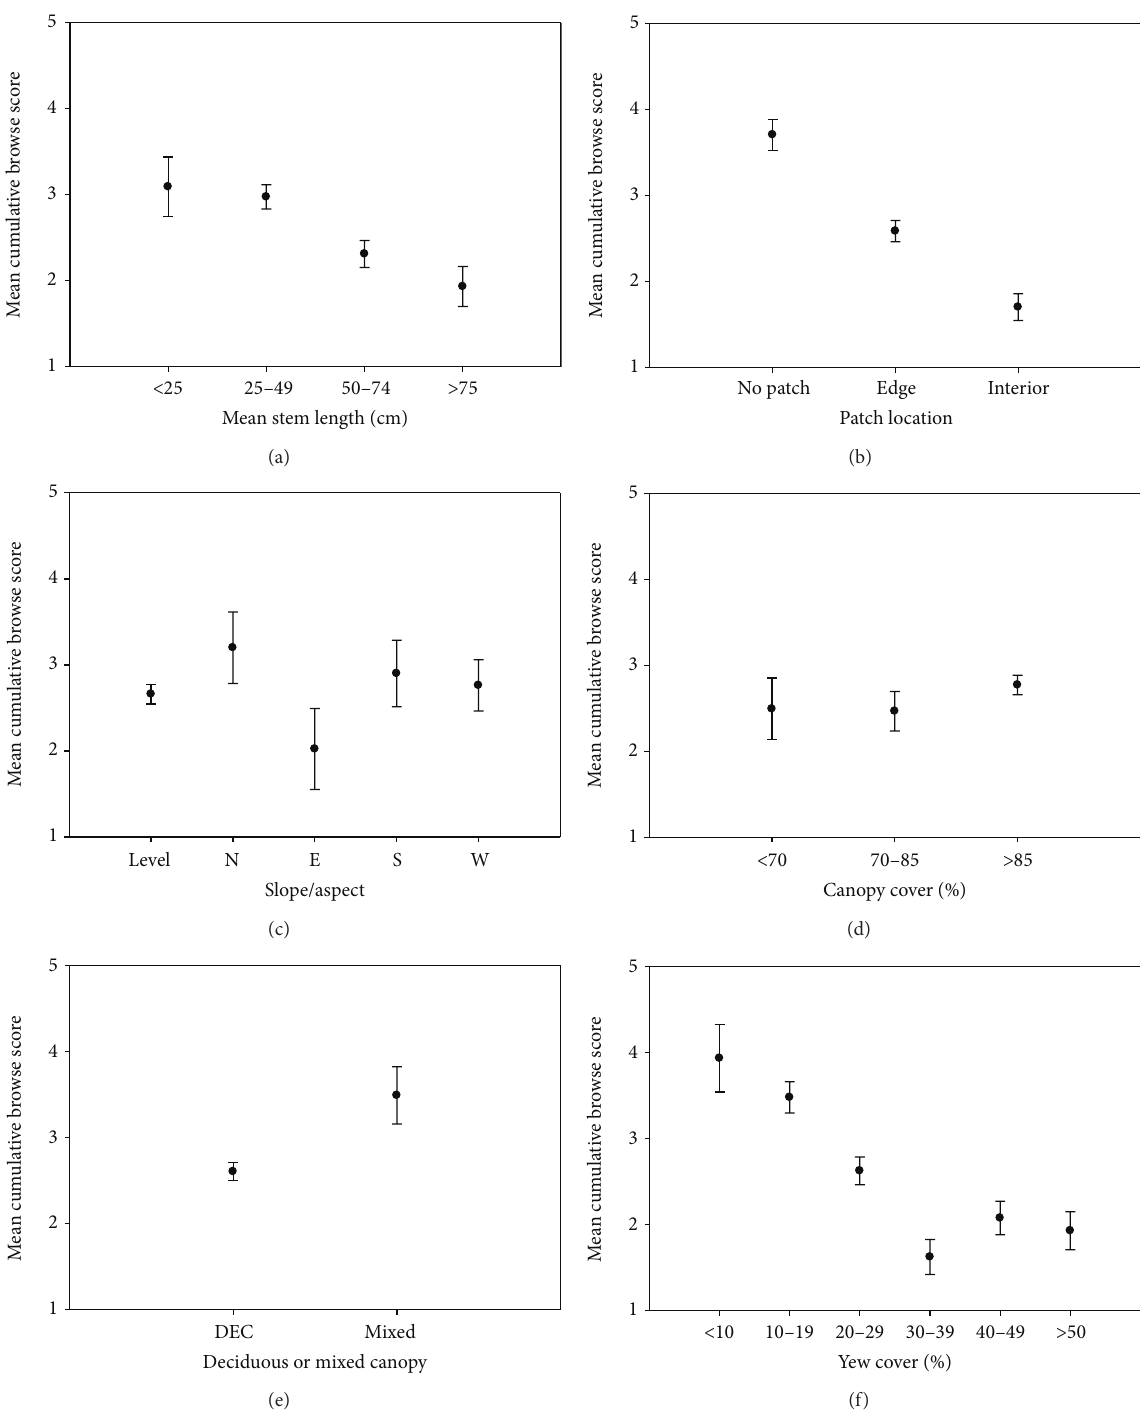
Figure 3: (a–f) Mean cumulative browsing score ( ± 1 SE) for clusters of Canada yew stems in relation to various predictor variables from 24 stands in Marquette and Alger counties, MI, 2001-2002. Cumulative browse scores were based on the proportion of twigs browsed by deer during the previous three winters for each stem in a cluster (1 = < 5% twigs browsed, 2 = 6–25%, 3 = 26–50%, 4 = 51–75%, 5 = 76–95%, 6 = > 95%). Predictor variables were: (a) Mean length (cm) of individual Canada yew stems; (b) Location of stems in relation to Canada yew patch edge: No Patch = stems that do not form a discrete patch, Edge = stems < 1m from the edge of the patch, and Interior = stems ≥ 1m from the edge of the patch; (c) slope and aspect of the site surrounding the Canada yew stems; (d) percent forest canopy cover of the site surrounding the Canada yew stems; (e) composition of forest surrounding the Canada yew stems (DEC = < 25% conifer, MIXED = ≥ 25% conifer); (f) percent Canada yew cover in the forest stand, based on 11m radius plots. See Section 2 for additional details about predictor